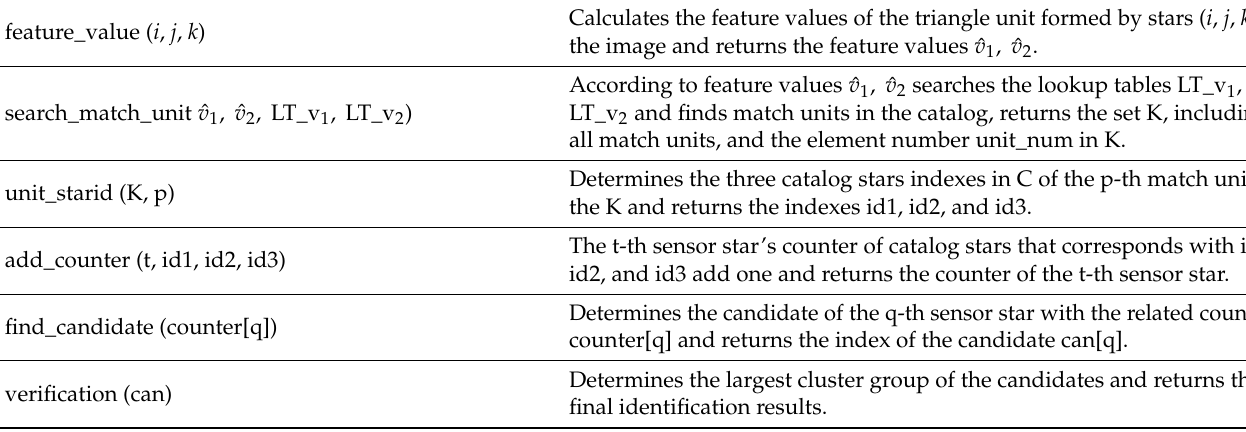
Table 2. Algorithm functions and brief